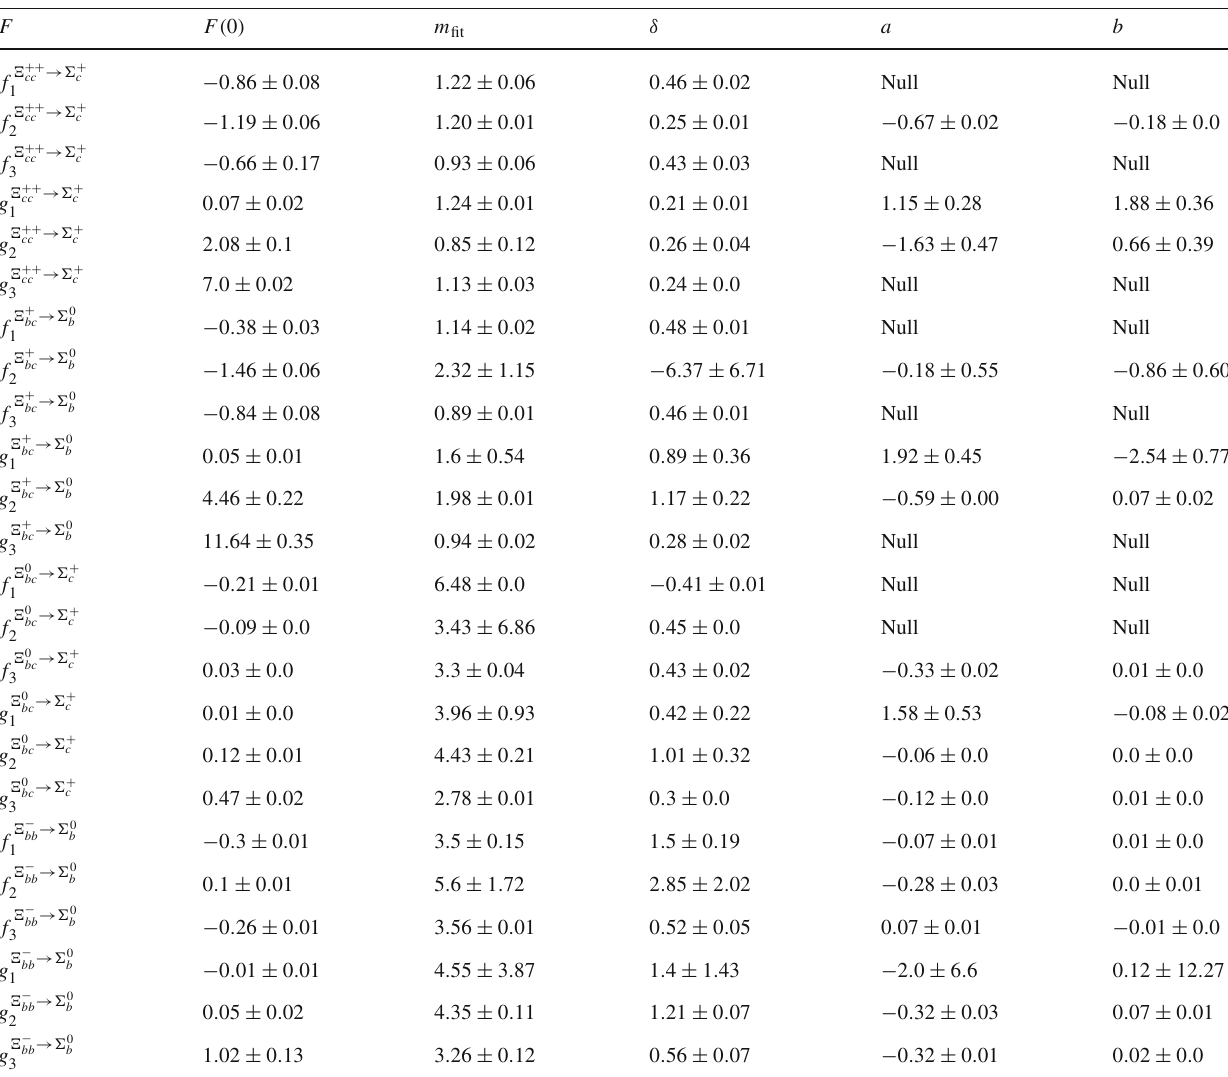
→ (cid:3) ( 0 ) , m δ , a and b correspond to the five fitting parameters in Eq. (41). The form √ fit , Q (cid:2) q 1 q 2 . F 2 → (cid:3) 2 times those of (cid:2) QQ (cid:2) q Q (cid:2) q 1 q 2 , which are not shown explicitly in this 2